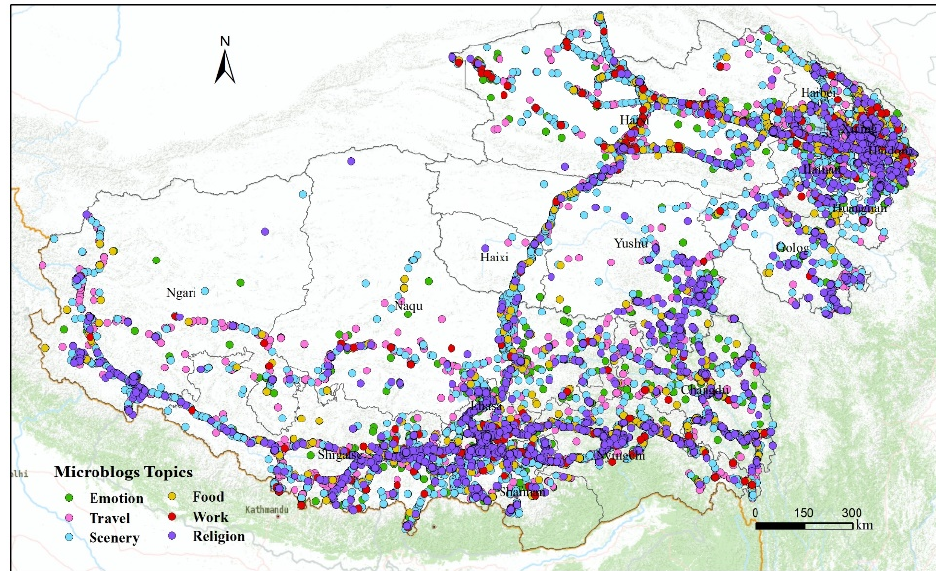
Figure 5. Spatial distribution of topics extracted from tourist microblogs.